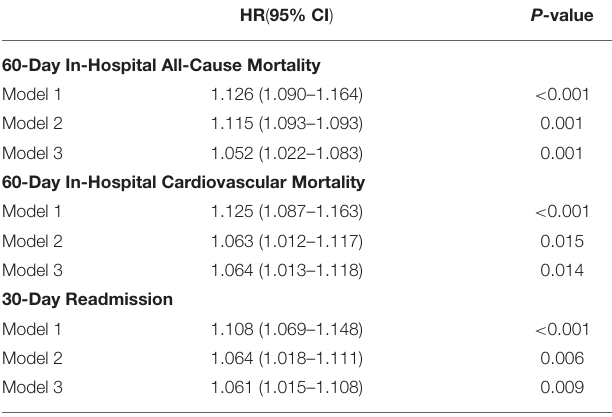
TABLE 2 | Risk of short-term events for each 1-point increase in MELD-XI score. HR ( 95% CI ) P